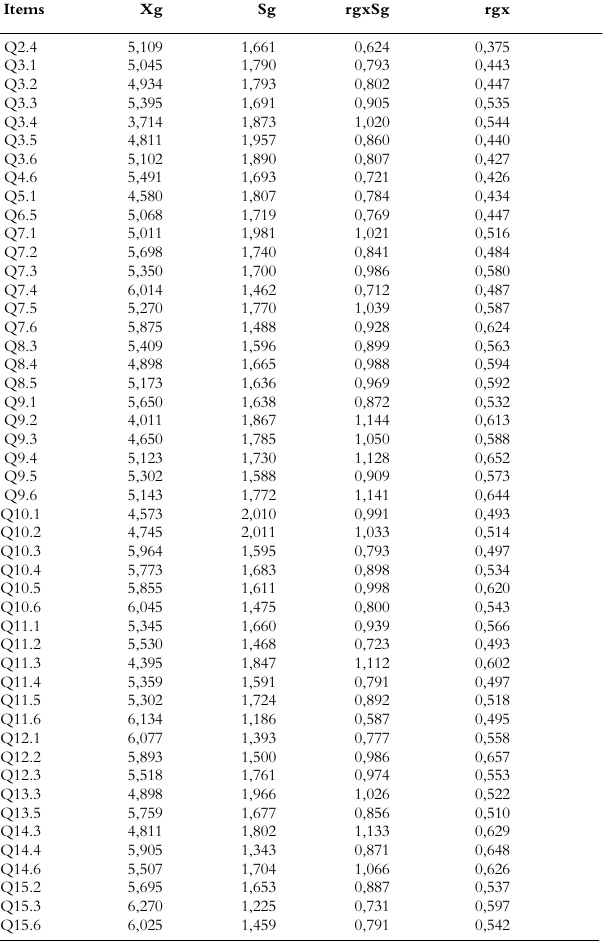
TABLE 9 ITEM STATISTICSIN RESPECTOF SCALE II